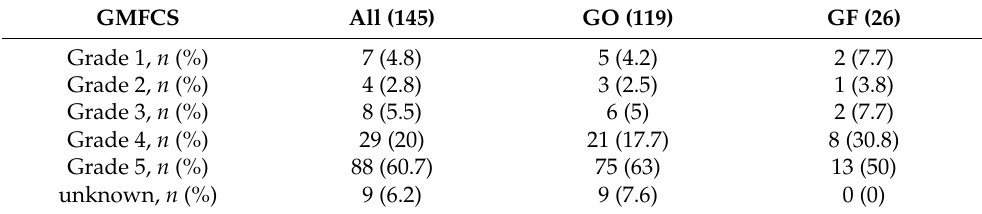
Table 1. Subgrouping of patients in the long term based on grade of neurological impairment according to Gross Motor Function Classification System